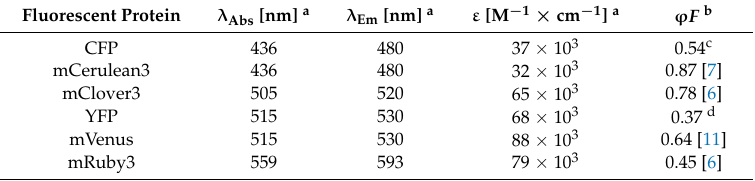
Table 1. Photophysical properties of the recombinant purified fluorescent